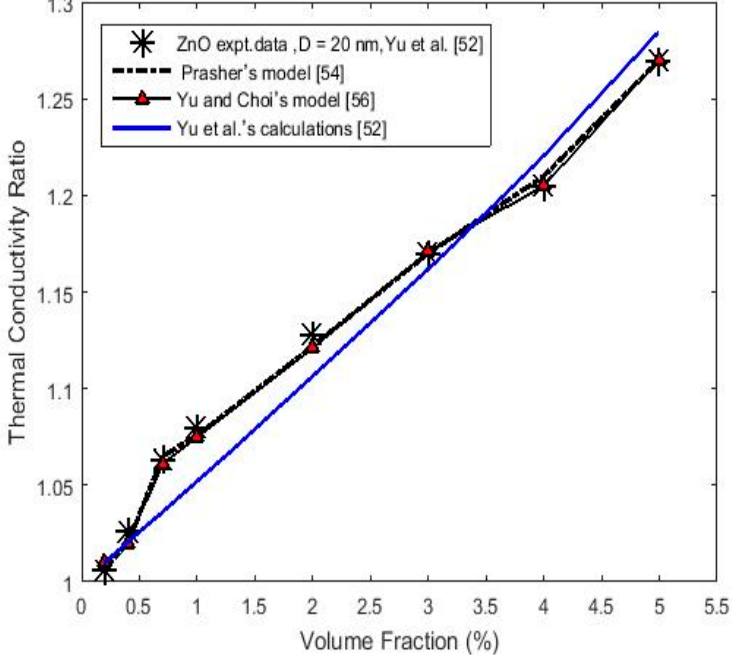
Figure 2. (Color online) Calculated thermal conductivity ratio (K ceff /K m ) versus the nanoparticle volume fraction for a ZnO–ethylene glycol (EG) nanofluid, using the Prasher’s (Equation (1)) and Yu and Choi’s models (Equation (6)). Experimental data are from [52]. The solid blue-line represents Yu et al.’s calculations [52]. Table 1. The nanoparticle and base fluid data at T = 300 K.